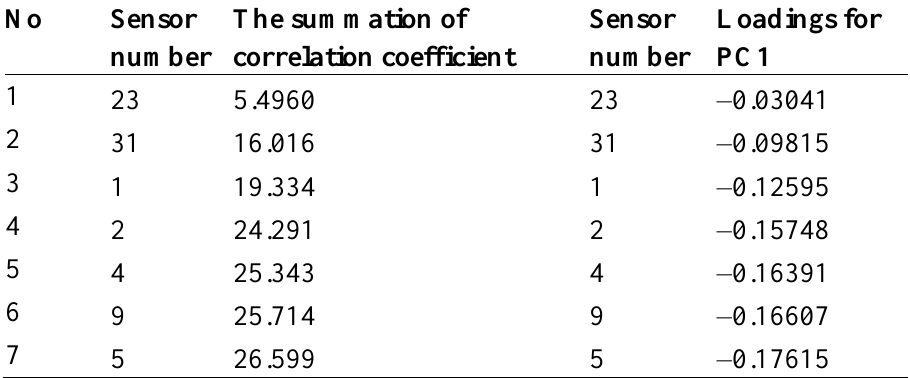
Table 4. The value of total correlation coefficient and loadings of PC1 for seven sensors.